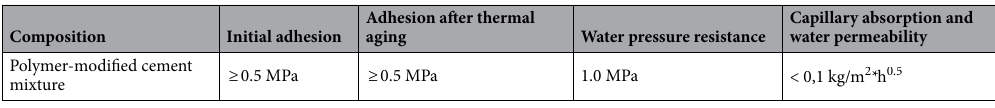
Table 2. Technical data of the commercial Mineral coating.